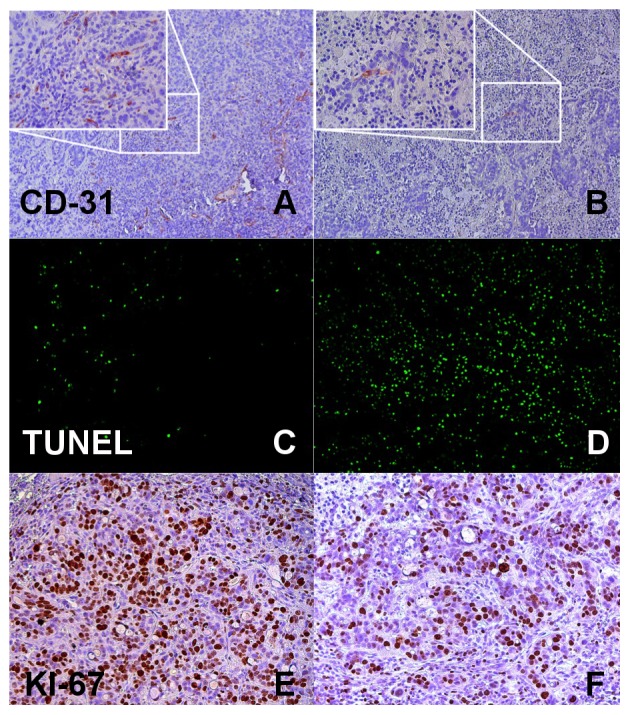
Immunohistochemical analysis.Representative immunohistochemical stainings for microvascular density (CD-31, A and B), apoptosis (TUNEL, C and D), and proliferation (Ki-67, E and F) in the therapy (right) and control group (left). Note the lower number of CD-31 and Ki-67 positive cells (stained in brown, B and F) and the higher number of cells positive for TUNEL (stained in fluorescent green, D) in the therapy group.